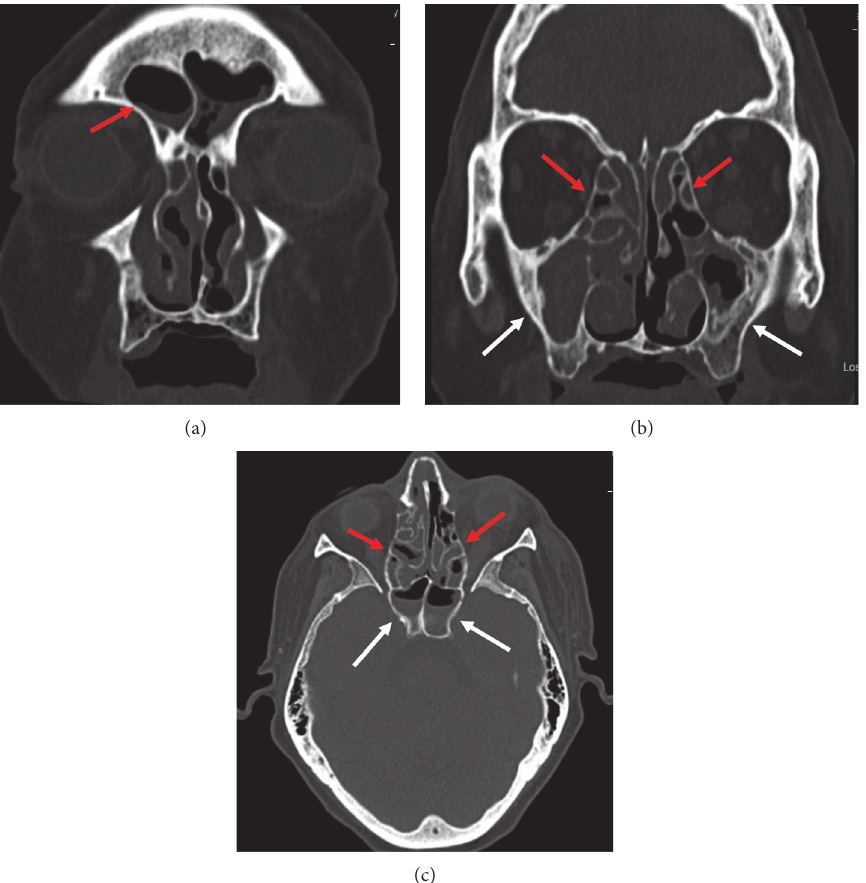
Figure 1: (a) Paranasal sinuses CTscan showed fluid level of frontal sinuses, (b) mucosal thickening of bilateral maxillary (white arrows) and ethmoid sinuses (red arrows), and (c) mucosal thickening of bilateral ethmoid sinuses (red arrows) and fluid level of bilateral sphenoidal sinuses (white arrows).